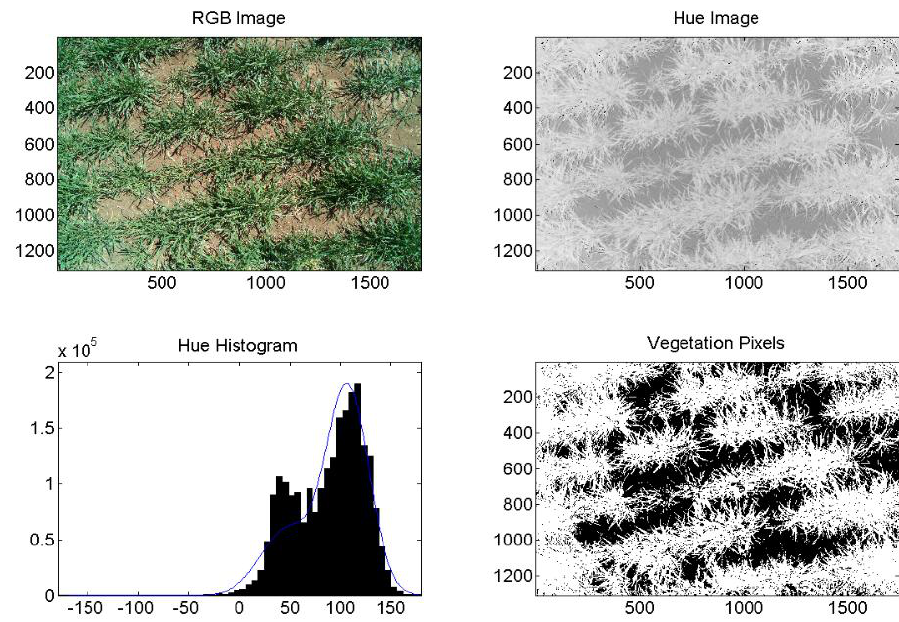
Figure 9. Example of Fuji image analysis for wheat, DOY 88, 2013, healthy, 100%. Axes on images are in pixels. Pixels classified as vegetation are shown in white (lower right).